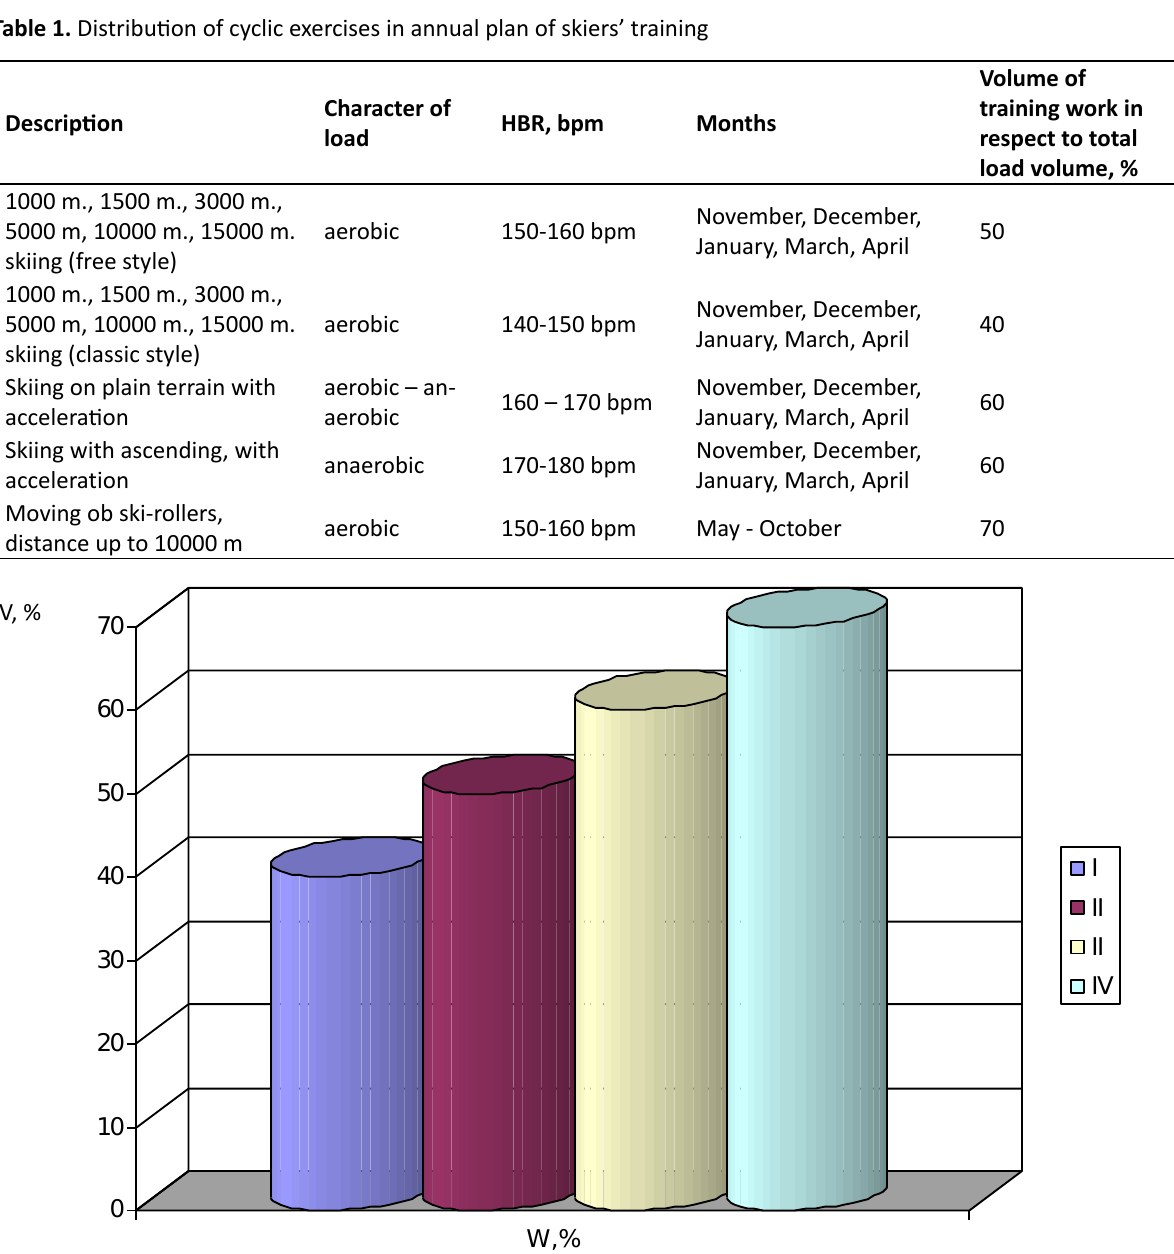
Fig. 1 . Distribution of physical load in skiers’ annual training plan: I, II, III, IV – zones of work; V – volume of cyclic load; I zone – work with moderate power; II zone – work with high power; III zone – work with sub-maximal power; IV zone – work with maximal power; W, % - volume of training work in respect to total load volume.